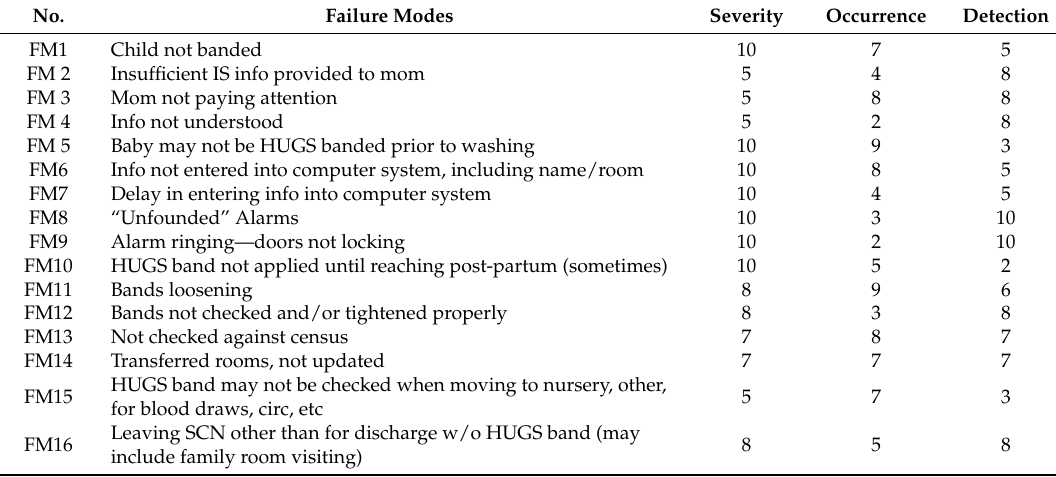
Table 1. Risk indexes (S, O, D) in failure mode and effects analysis (FMEA) for preventing infant